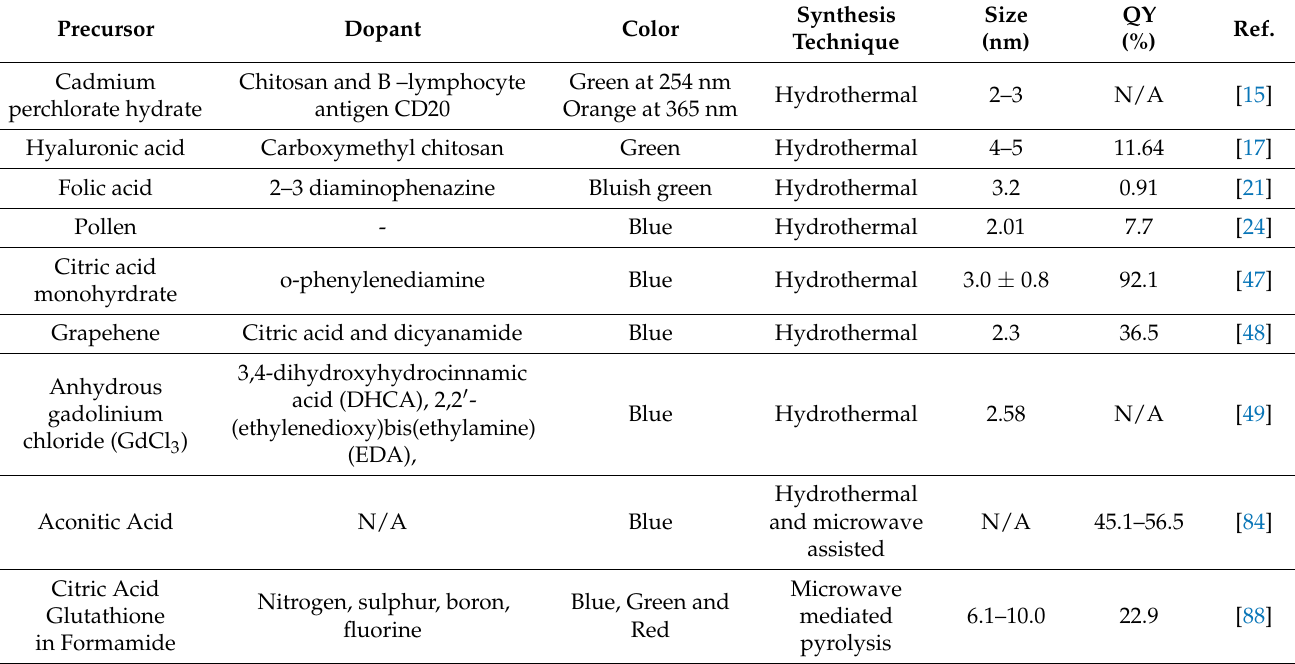
Table 2. Precursor, doping agent, color, synthesis technique, size, and quantum yield (QY) of various